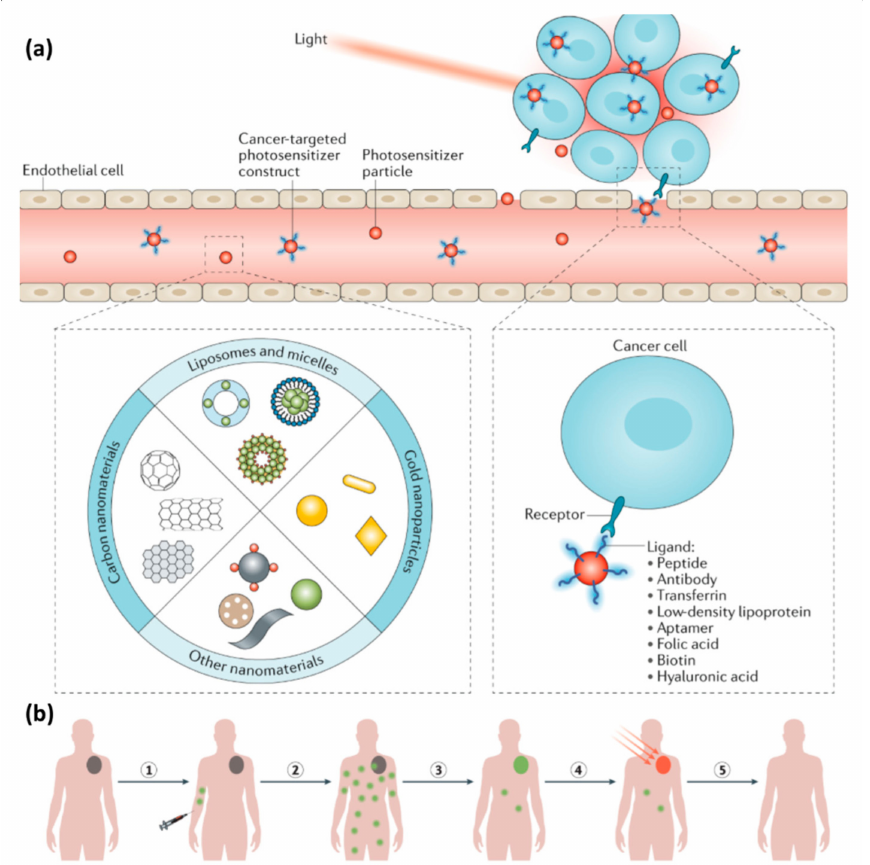
Figure 2. Use of nanoparticles and high-affinity ligands to target cancer and increase the spatial resolution of photothermal therapy (PTT): ( a ) nanoparticle accumulation in cancer cells through cancer-target ligands, where either the nanoparticles or the ligands can come from a wide range of materials; ( b ) scheme of drug accumulation in the cancer site—step 1 shows the nanoparticle injection, step 2 evidences the nanoparticle distribution in the human body, step 3 shows the nanoparticle accumulation in the tumor, step 4 highlights the photonic nanomedicine being used, and step 5 shows the complete tumor regression after the therapy. Copyright (2020) Springer Nature